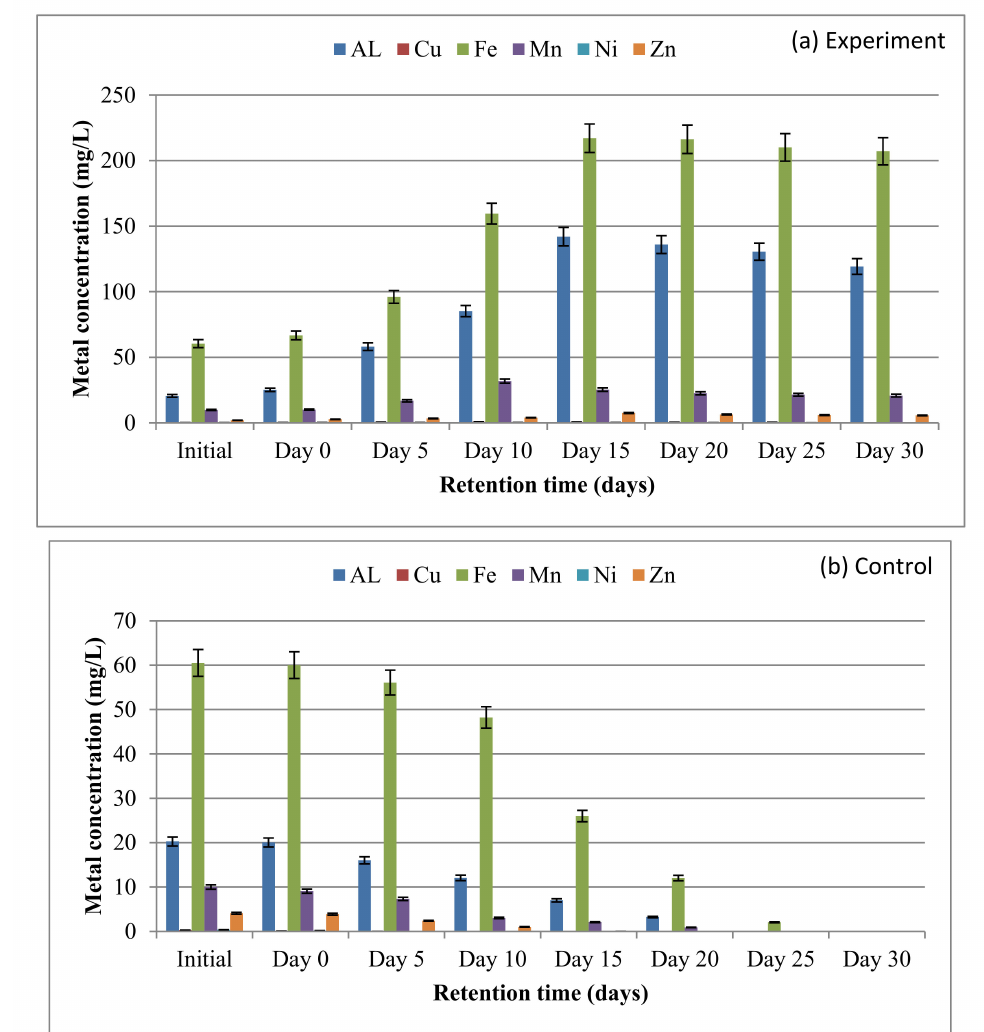
Figure 4. ( a ) Variation of the metal concentration in substrate (treatment wetland) within 30 days HRT and with a hydraulic loading rate of 3 L/day. ( b ) Variation of the metal concentration in substrate (control wetland) within 30 days HRT and with a hydraulic loading rate of 3